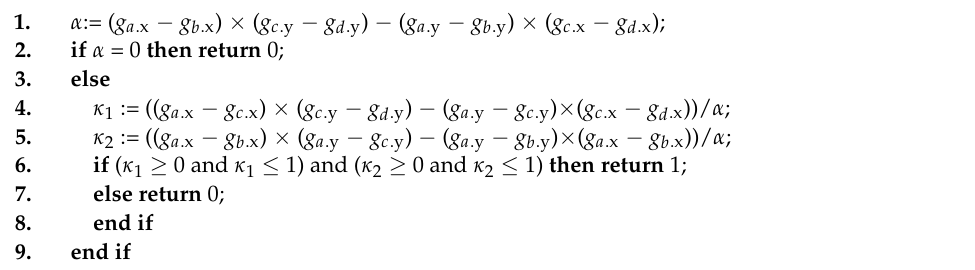
Algorithm 1. SegSegInt(point g a , point g b , point g c , point g d